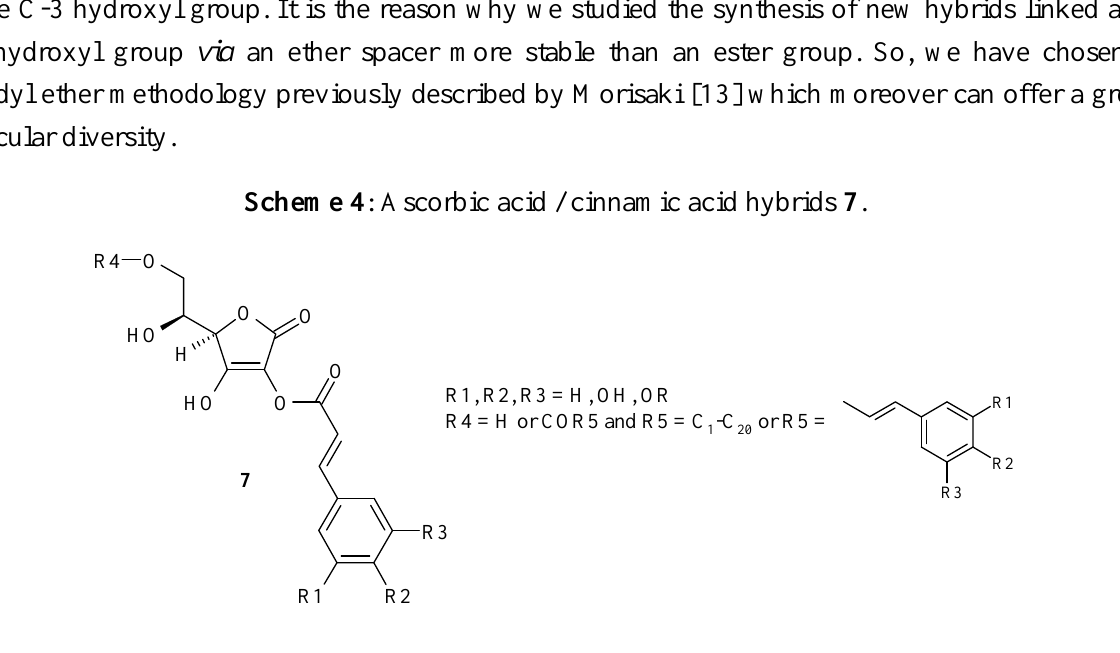
Table 1 : Octanol/water partition coefficient log P